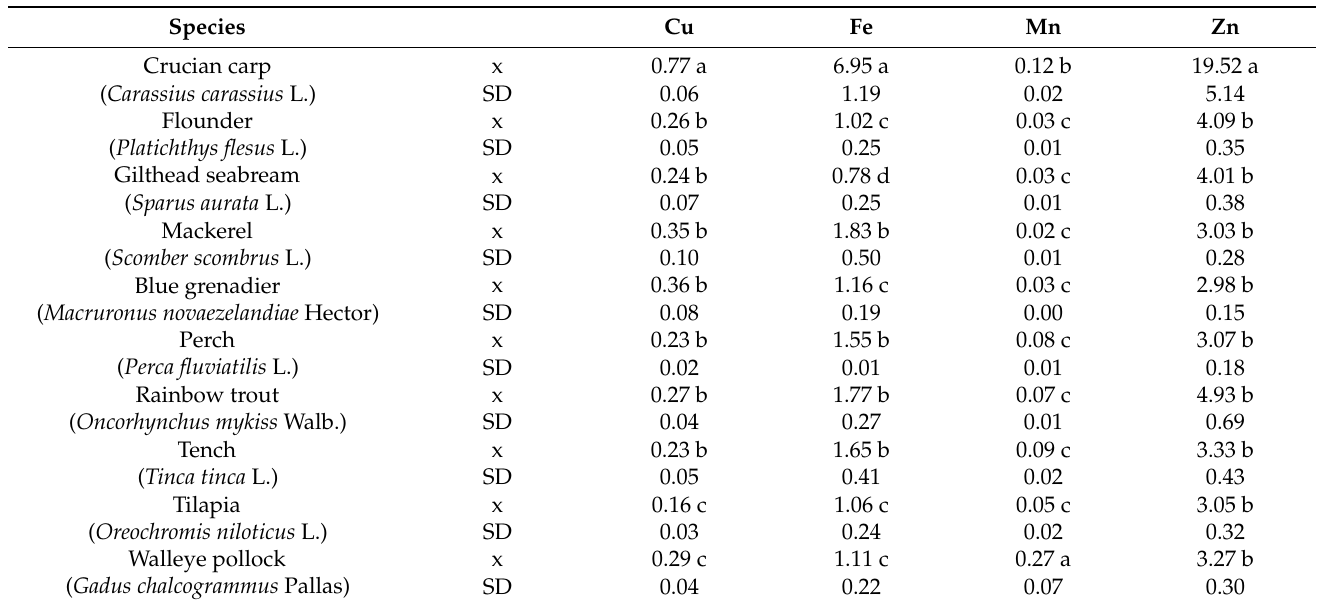
Table 1. Differences (x ± SD) in the contents of heavy metals (mg/kg wet weight) in the same organs of